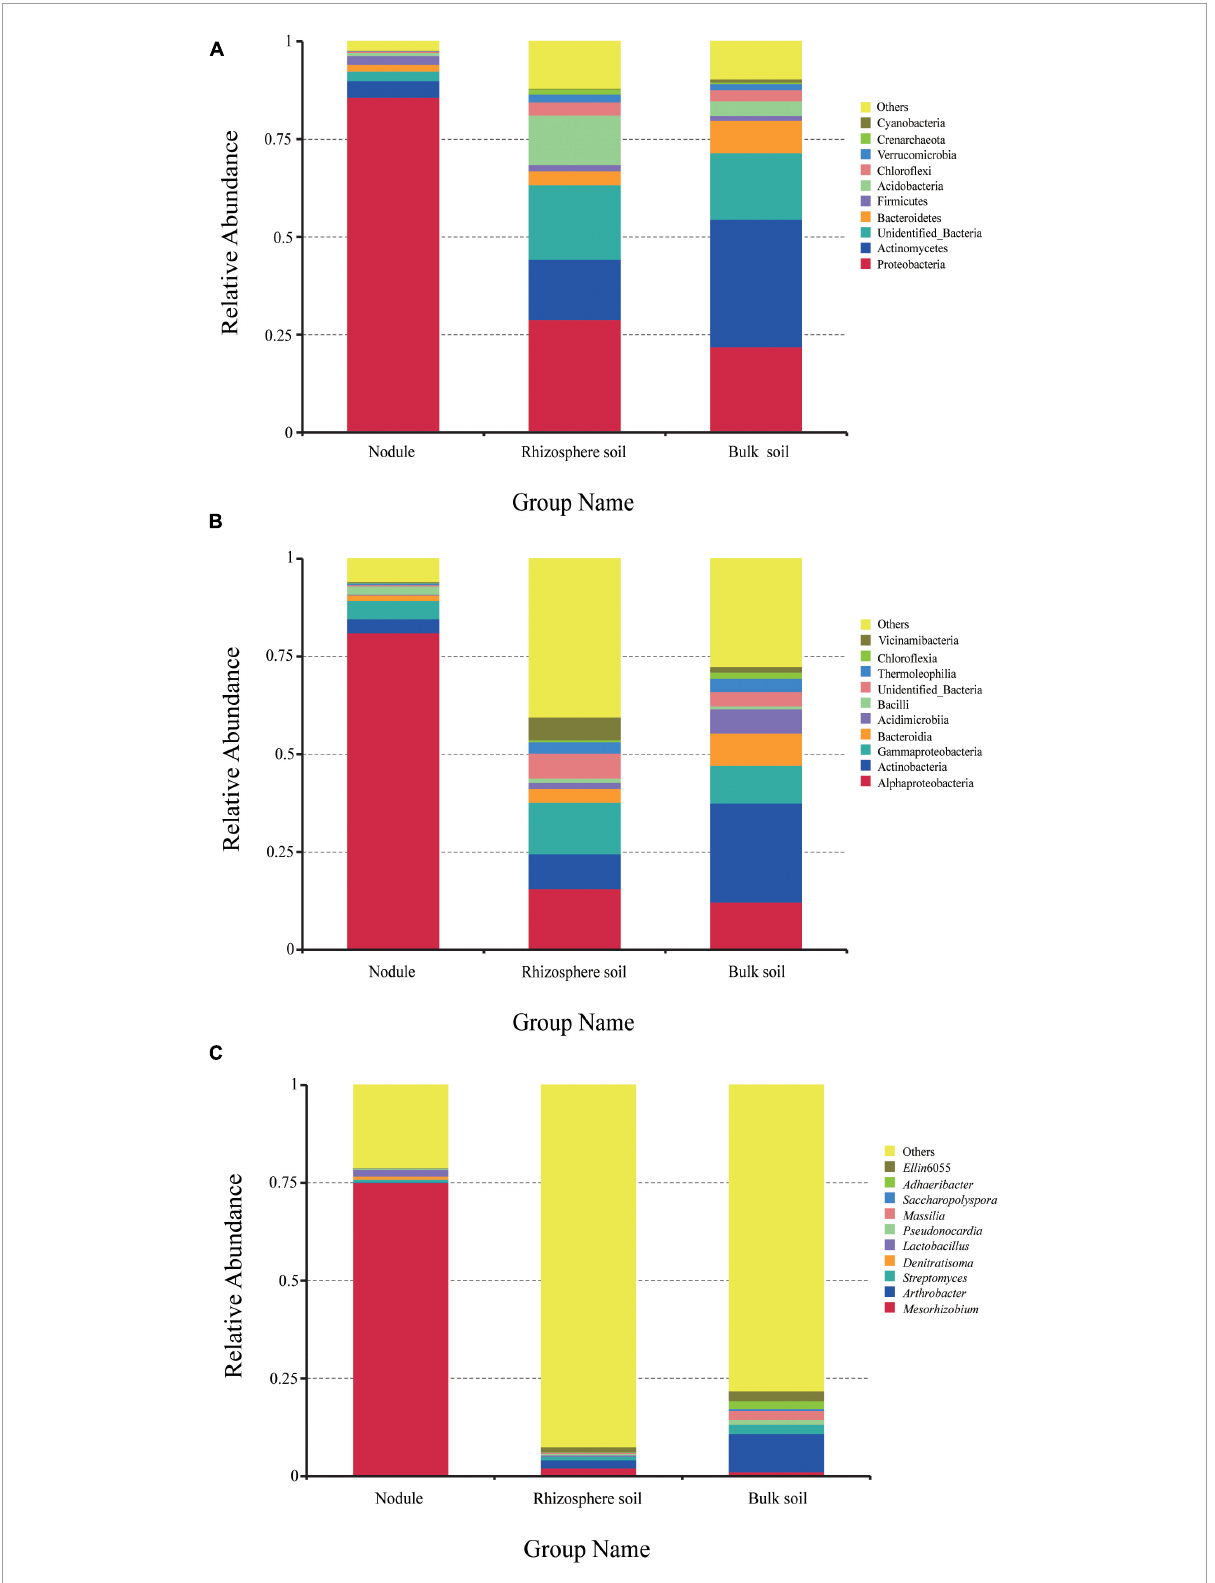
FIGURE3 The relative abundance of endophytic bacteria in the three groups of samples at different taxonomic levels. (A) is the relative abundance of bacteria at the phylum level. (B) is the relative abundance of bacteria at the class level. (C) is the relative abundance of bacteria at the genus level.